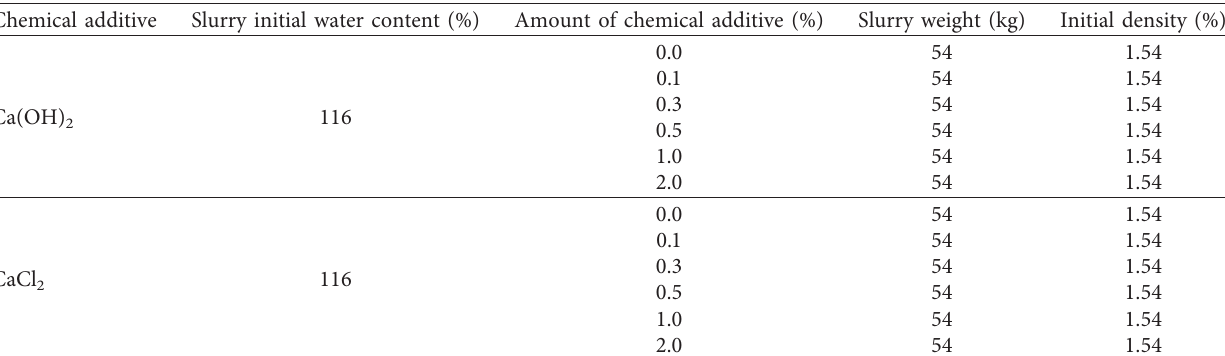
Figure 1: Schematic of vacuum consolidation device. Table 3: Programme of vacuum preloading